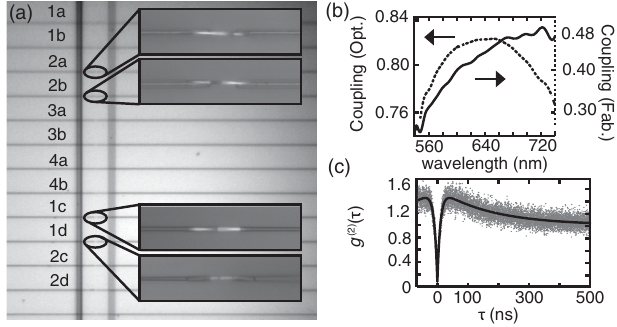
FIG. 6. (a) The coupling region of the SiN chip used with three different waveguide designs, and zoomed-in images of the four devices integrated on consecutive waveguides of the same design. (b) Simulated coupling efficiencies from the NV into the SiN of the optimized (dashed line) and fabricated (solid line) devices. (c) Autocorrelation measurement via confocal collection of a NV in a diamond μ WG showing superb single photon character with antibunching down to